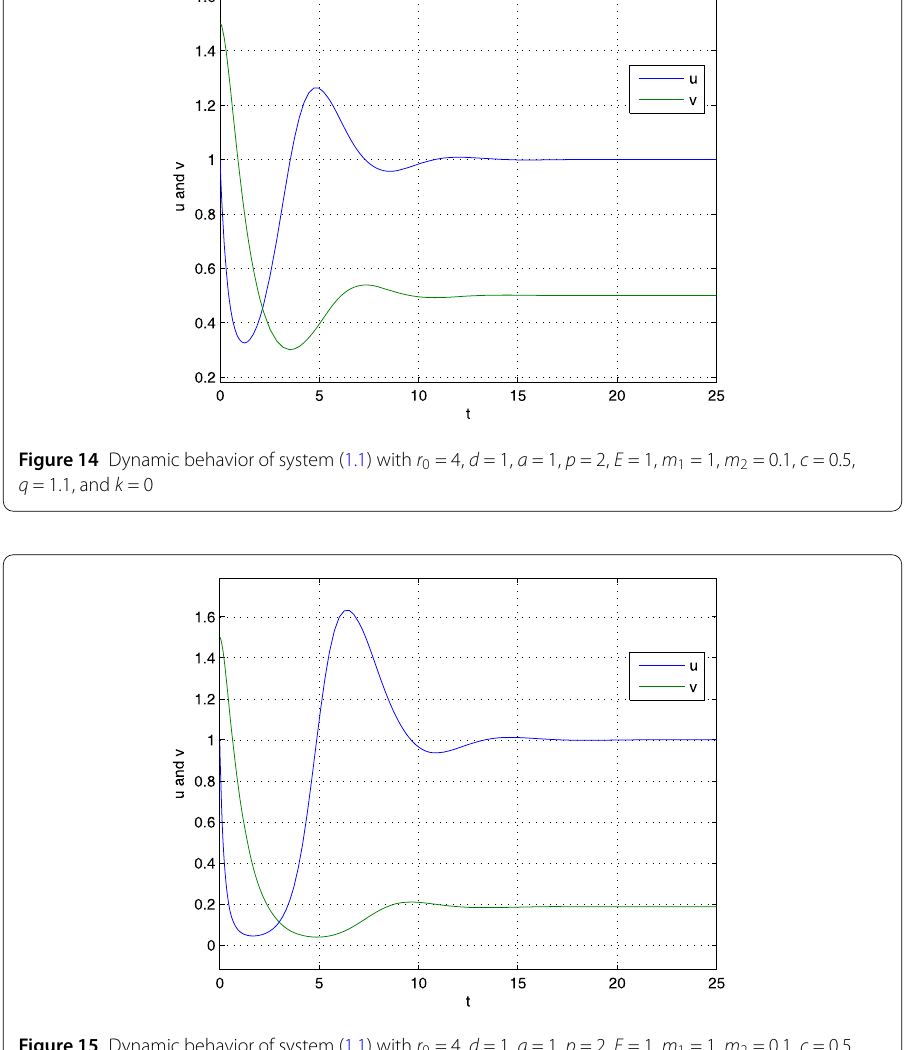
Figure 15 Dynamic behavior of system (1.1) with r 0 = 4, d = 1, a = 1, p = 2, E = 1, m 1 = 1, m 2 = 0.1, c = 0.5, q = 1.1, and k =